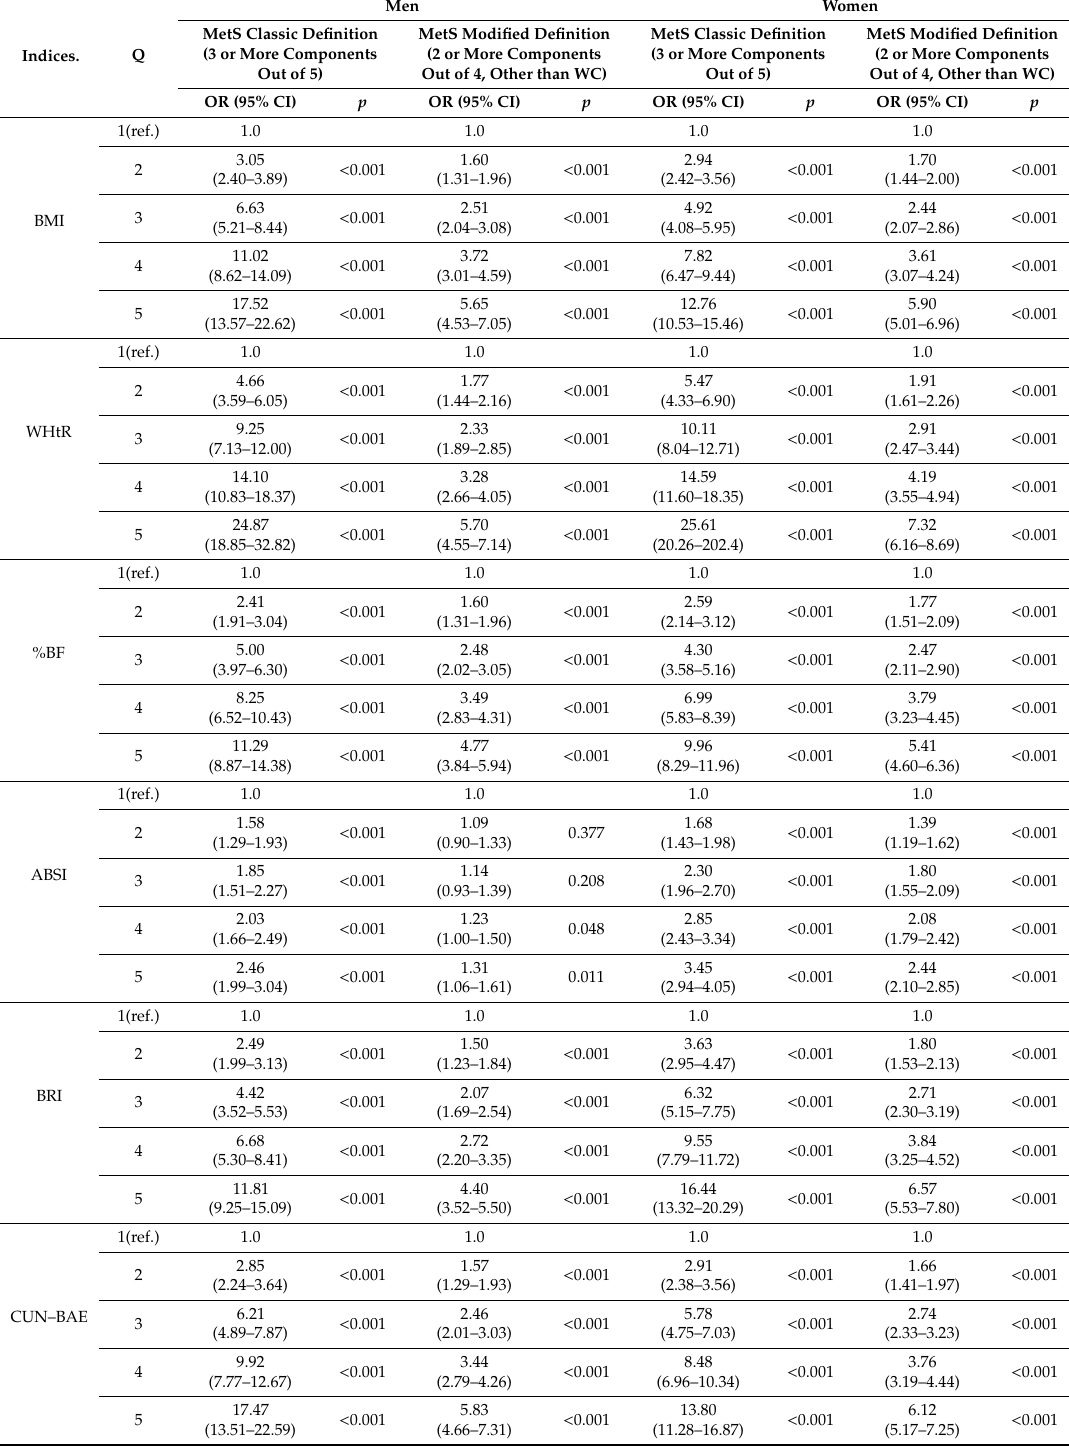
Table 4. Odds ratios and 95% confidence intervals for MetS, adjusted for age, education, smoking, physical activity, and alcohol